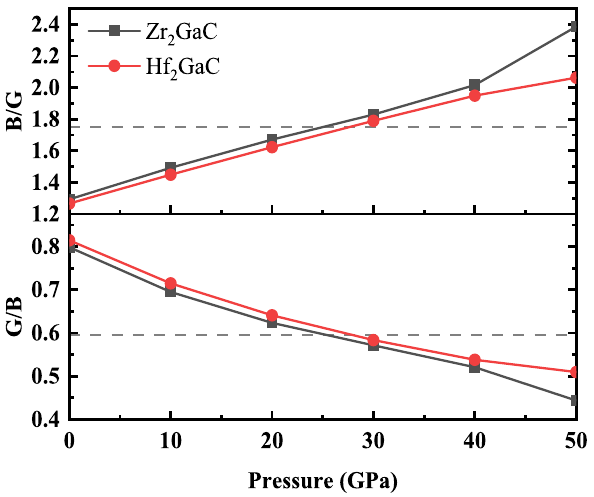
Figure 12. The effect of pressure on Pugh’s ratio for M 2 GaC MAX phase (M = Zr, Hf). The horizontal line in ( a ) is the proposed borderline between brittle and ductile